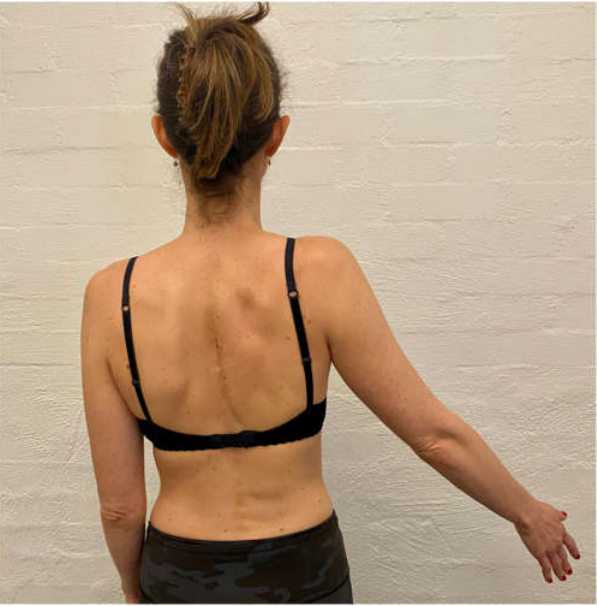
Figure 3. Upward rotation/elevation drill with the arm in 20 to 30° abduction.